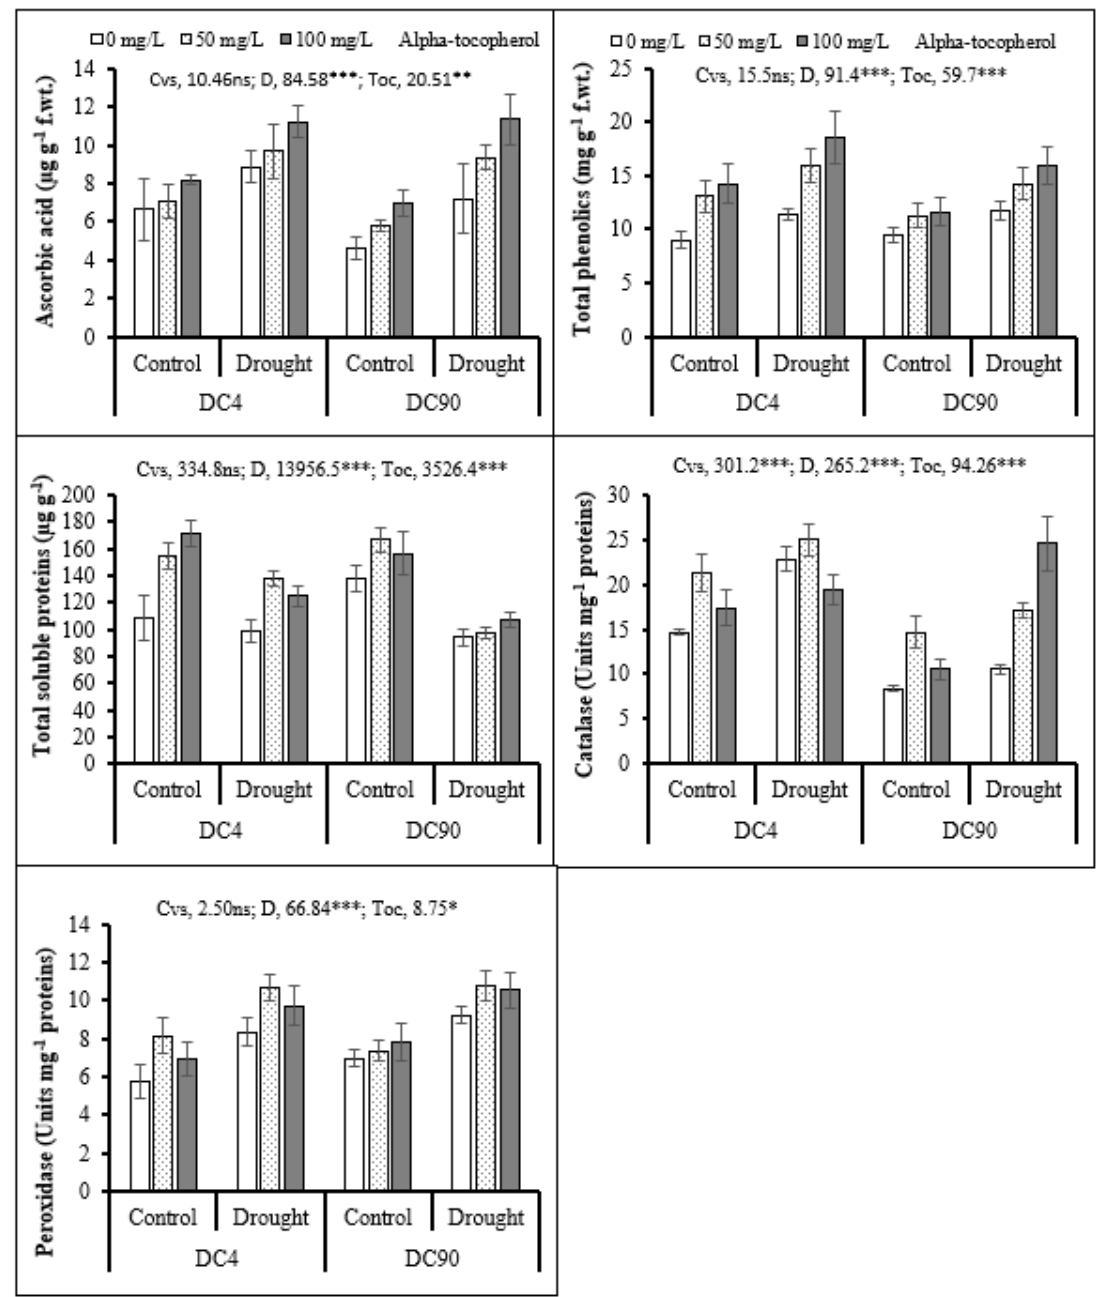
Figure 3. Effect of different levels of alpha-tocopherol on ascorbic acid, total phenolics, total soluble proteins and activities of catalase and peroxidase enzymes of 51-day-old carrot cultivar grown under control (normal watering) and drought (50% field capacity) stressed environments. Bars sharing different letter(s) for each parameter are significantly different from each other according to Duncan’s multiple range test ( p < 0.05). All the data represented are the average of three replications ( n = 3). Error bars represent standard deviation (SD) of three replicates. ns, non-significant, *, ** and ***; significant at 0.05, 0.01 and 0.001 levels.